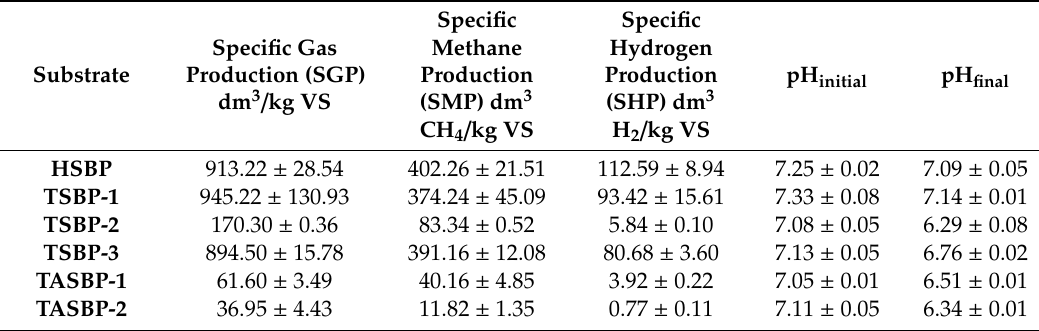
Table 2. Parameters of the batch digestion tests without